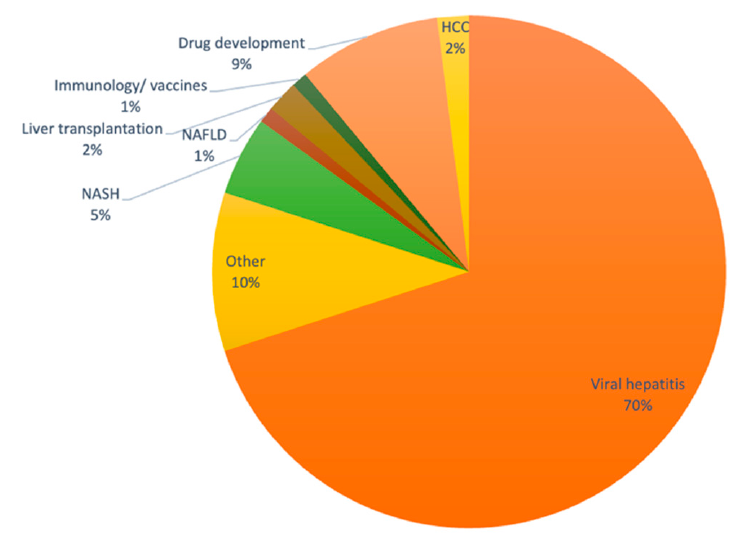
Figure 1. Hep-DART demographics. Area of expertise for conference attendees (N =148). Abbreviations: HCC: Hepatocellular carcinoma; NAFLD: Non-alcoholic fatty liver diseases; NASH: Non-alcoholic steatohepatitis.